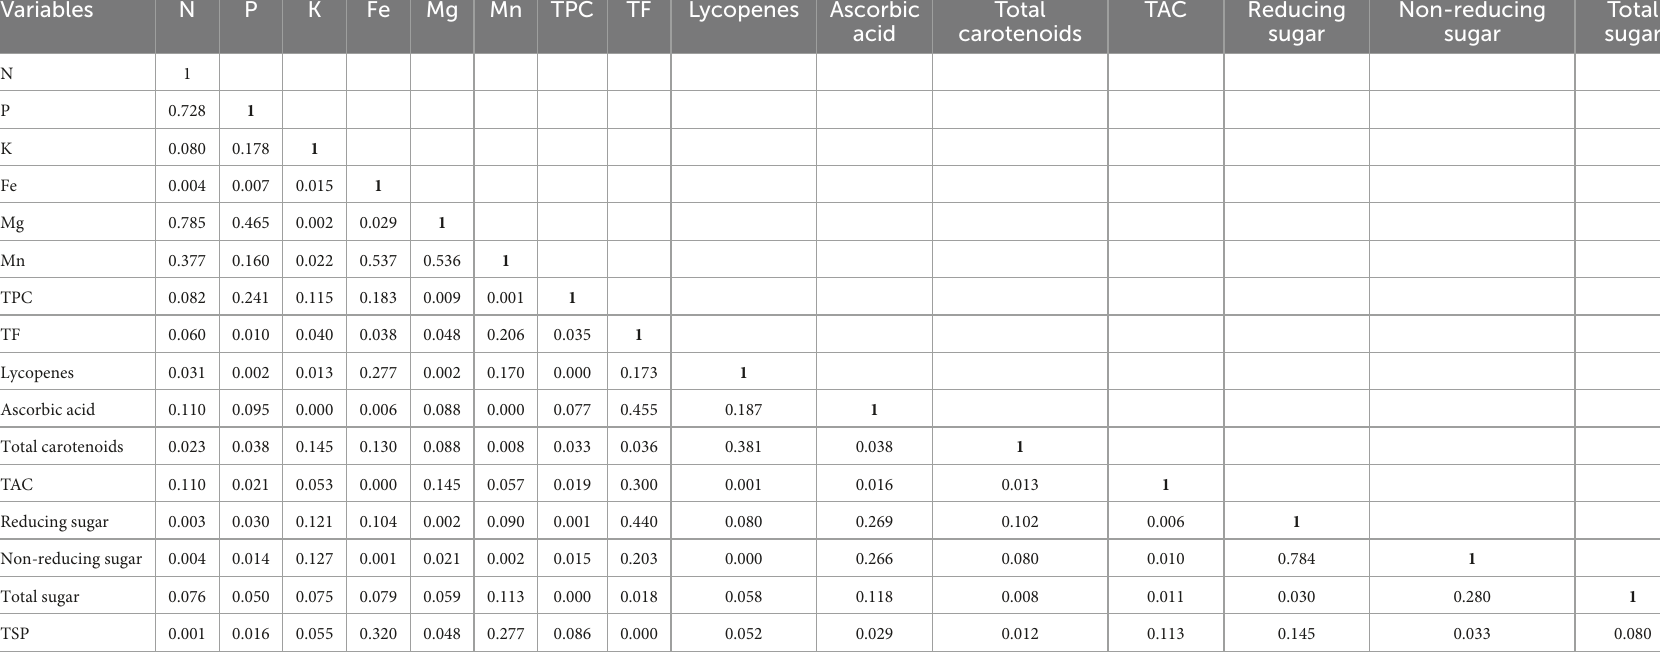
TABLE 7 Coefficients of determination (Pearson) between biochemical parameters of selective fruit